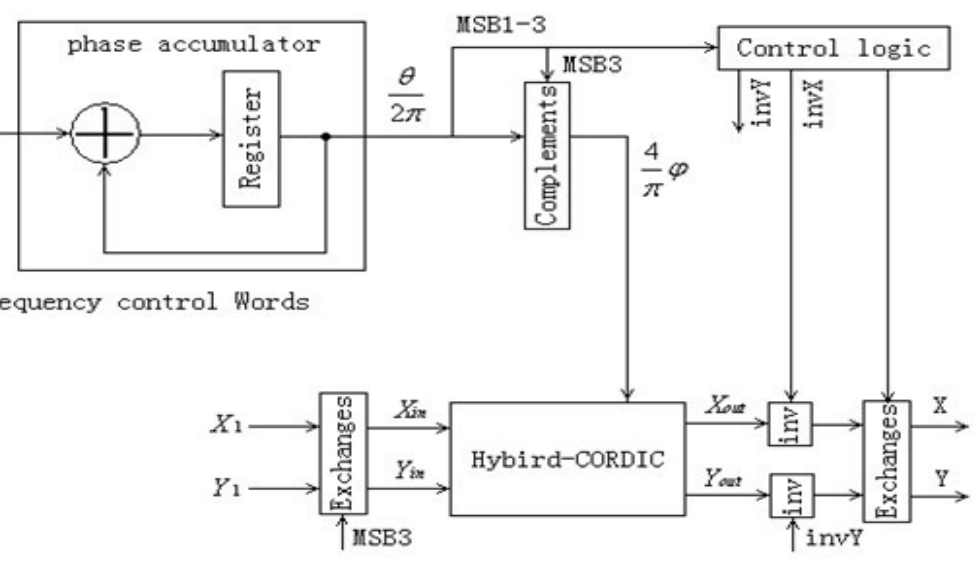
Fig. 4 the DDS structure based on Hybird-CORDIC